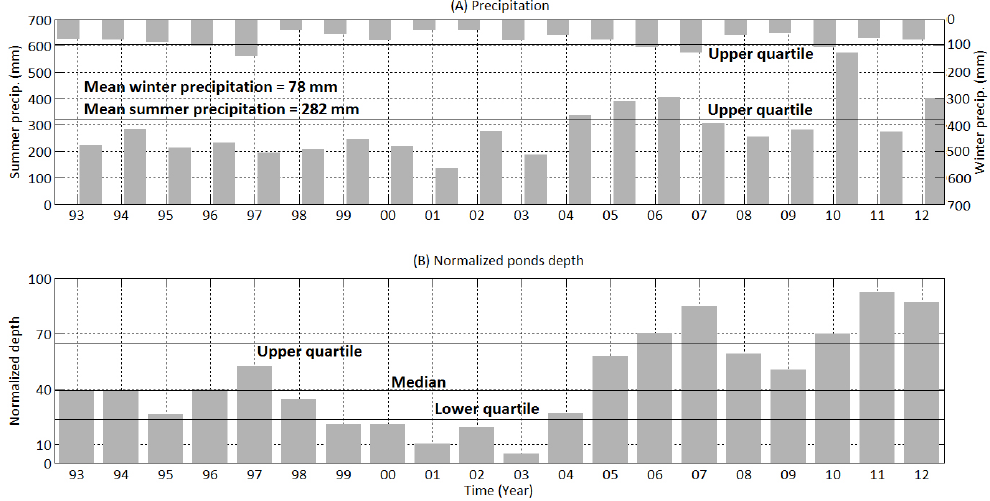
Fig. 2. (A) Total summer rainfall plus winter snow per hydrologic year. (B) Averaged and normalized depths of 12 ponds at St. Denis.